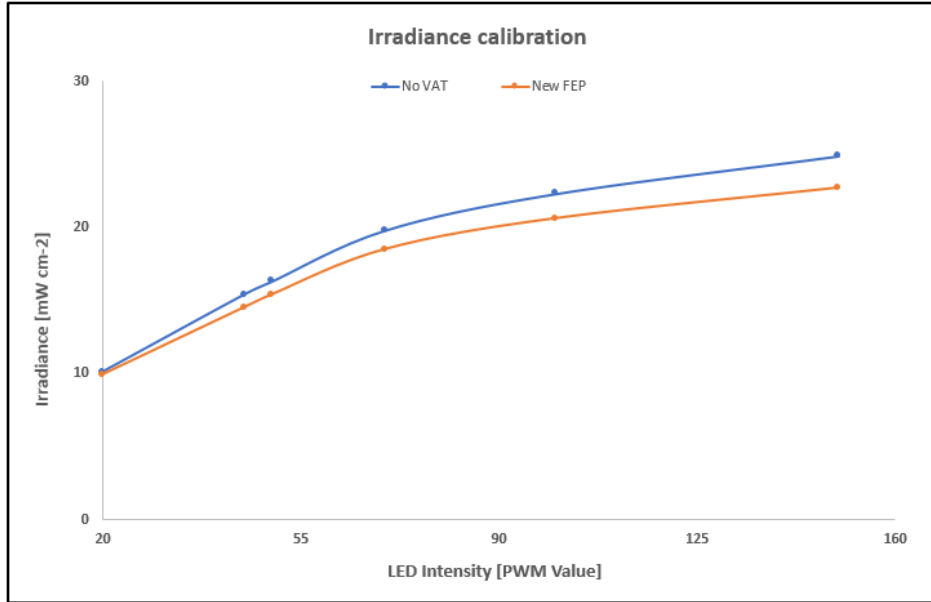
Figure 2. Irradiance calibration results depending on the LED intensity without vat and with a new FEP installed.